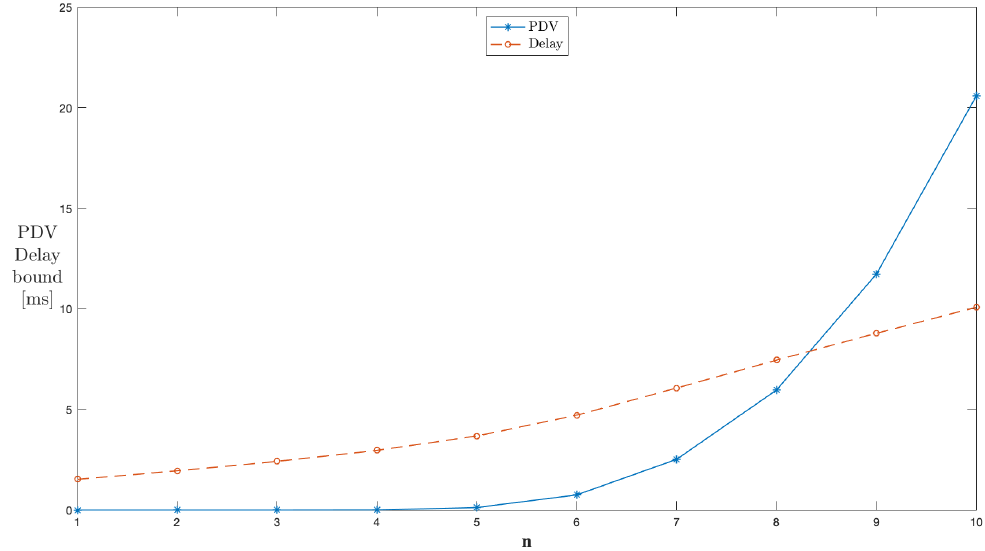
Figure 7. End-to-end concatenation of servers in series.